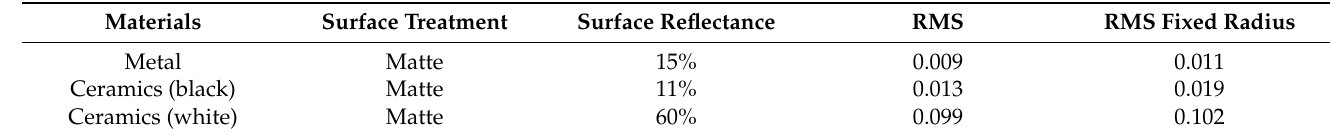
Table 3. Comparison of scanning